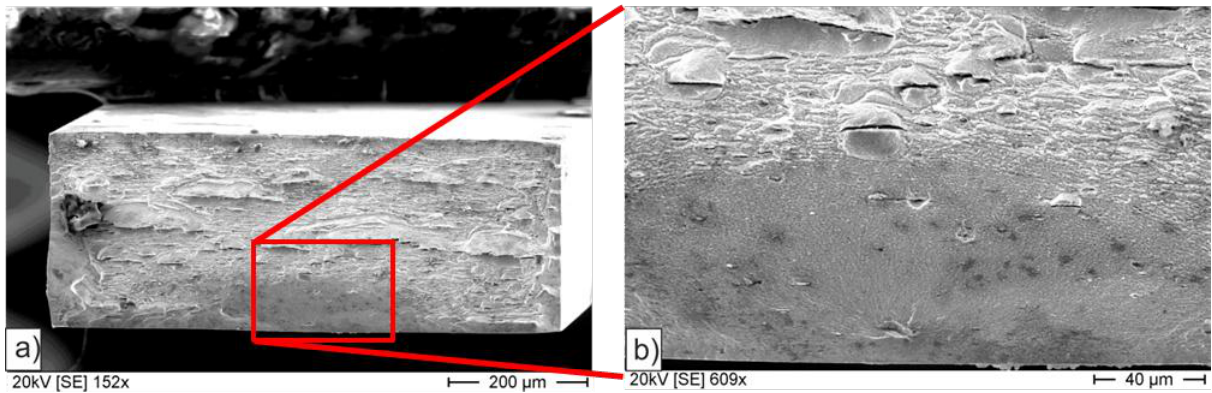
Figure 8. Fracture surface of t-HPT-10 ( a ) whole fracture surface ( b ) crack initiation area at the surface without nonmetallic inclusion and fatigue fracture surface.